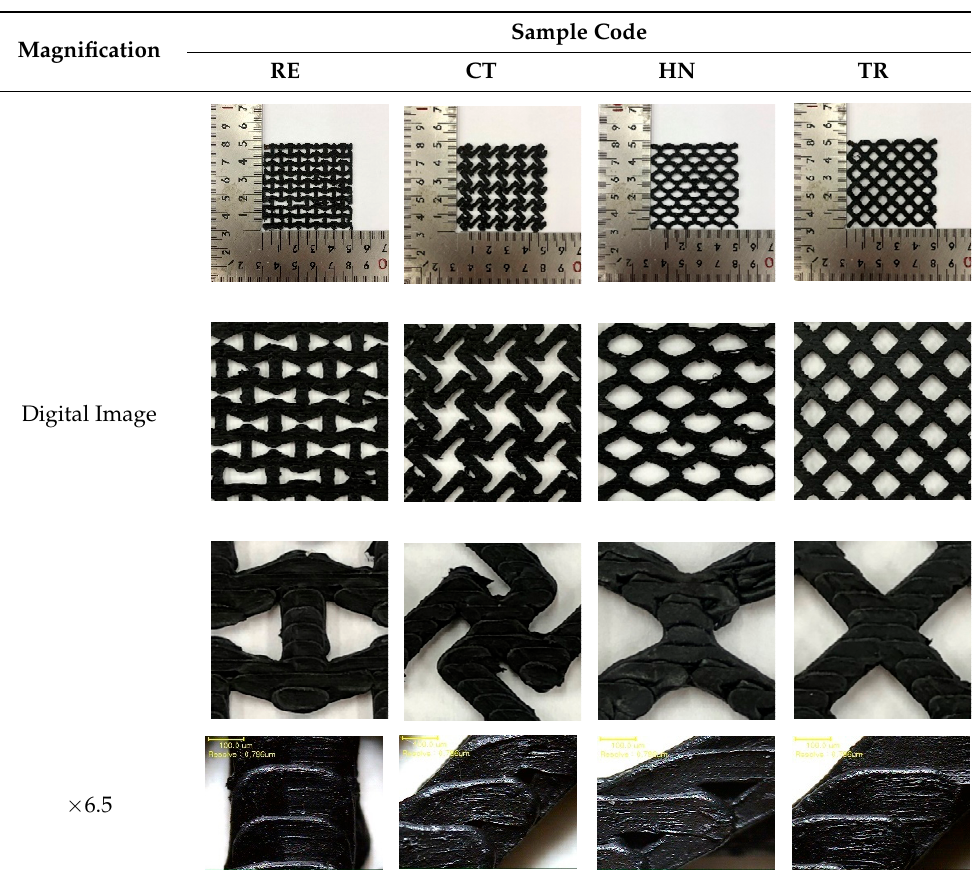
Table 2. Morphology of 4 types of CFDM 3D printed GR/PLA auxetic patterns.